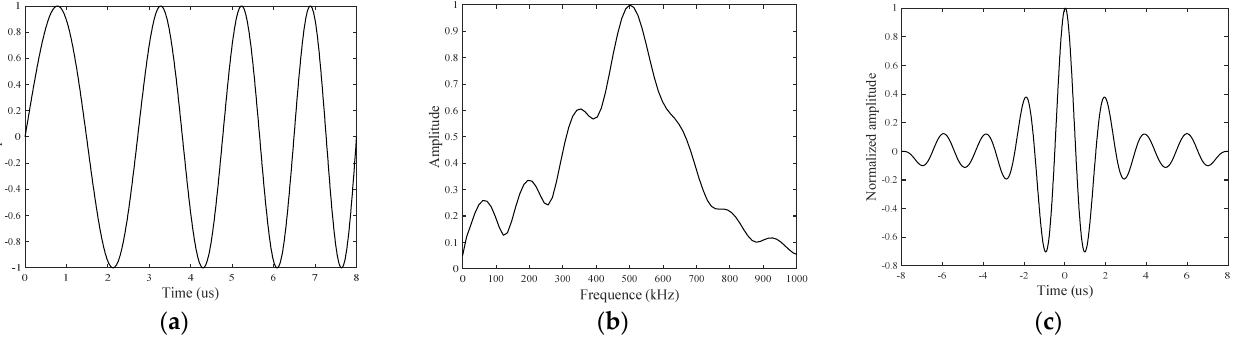
Figure 1. High-frequency L-Chirp signal: ( a ) waveform; ( b ) frequency spectrum; and ( c ) autocorrelation curve.